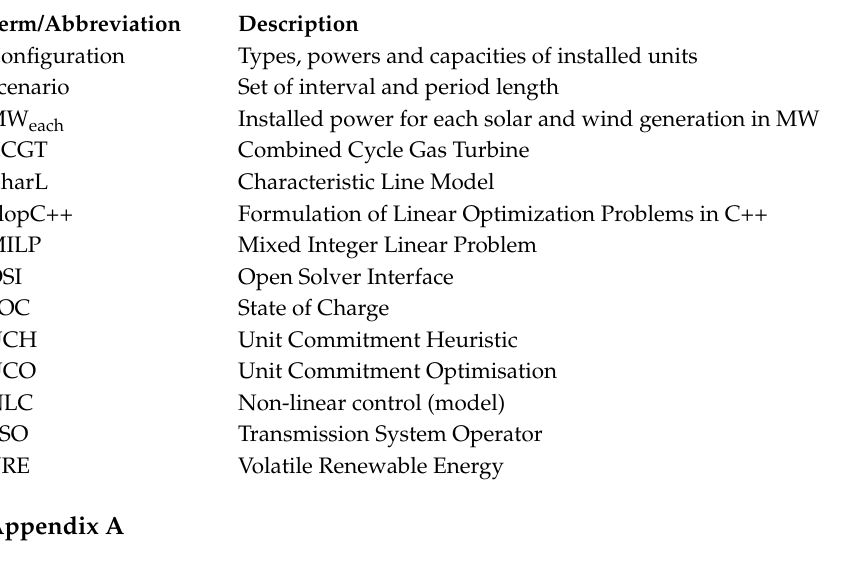
Table A1. Hardware setup used for the calculations.